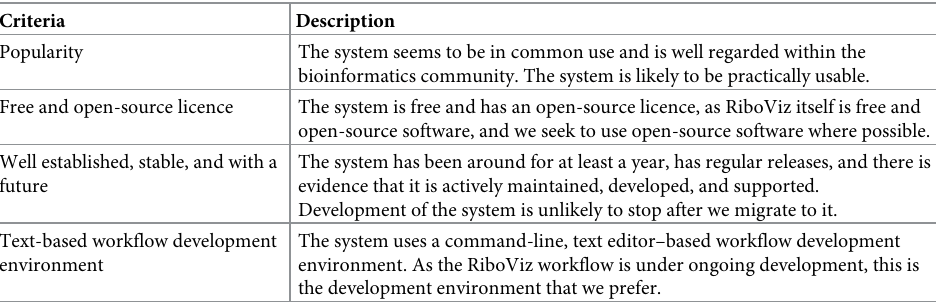
Table 2. Shortlisting